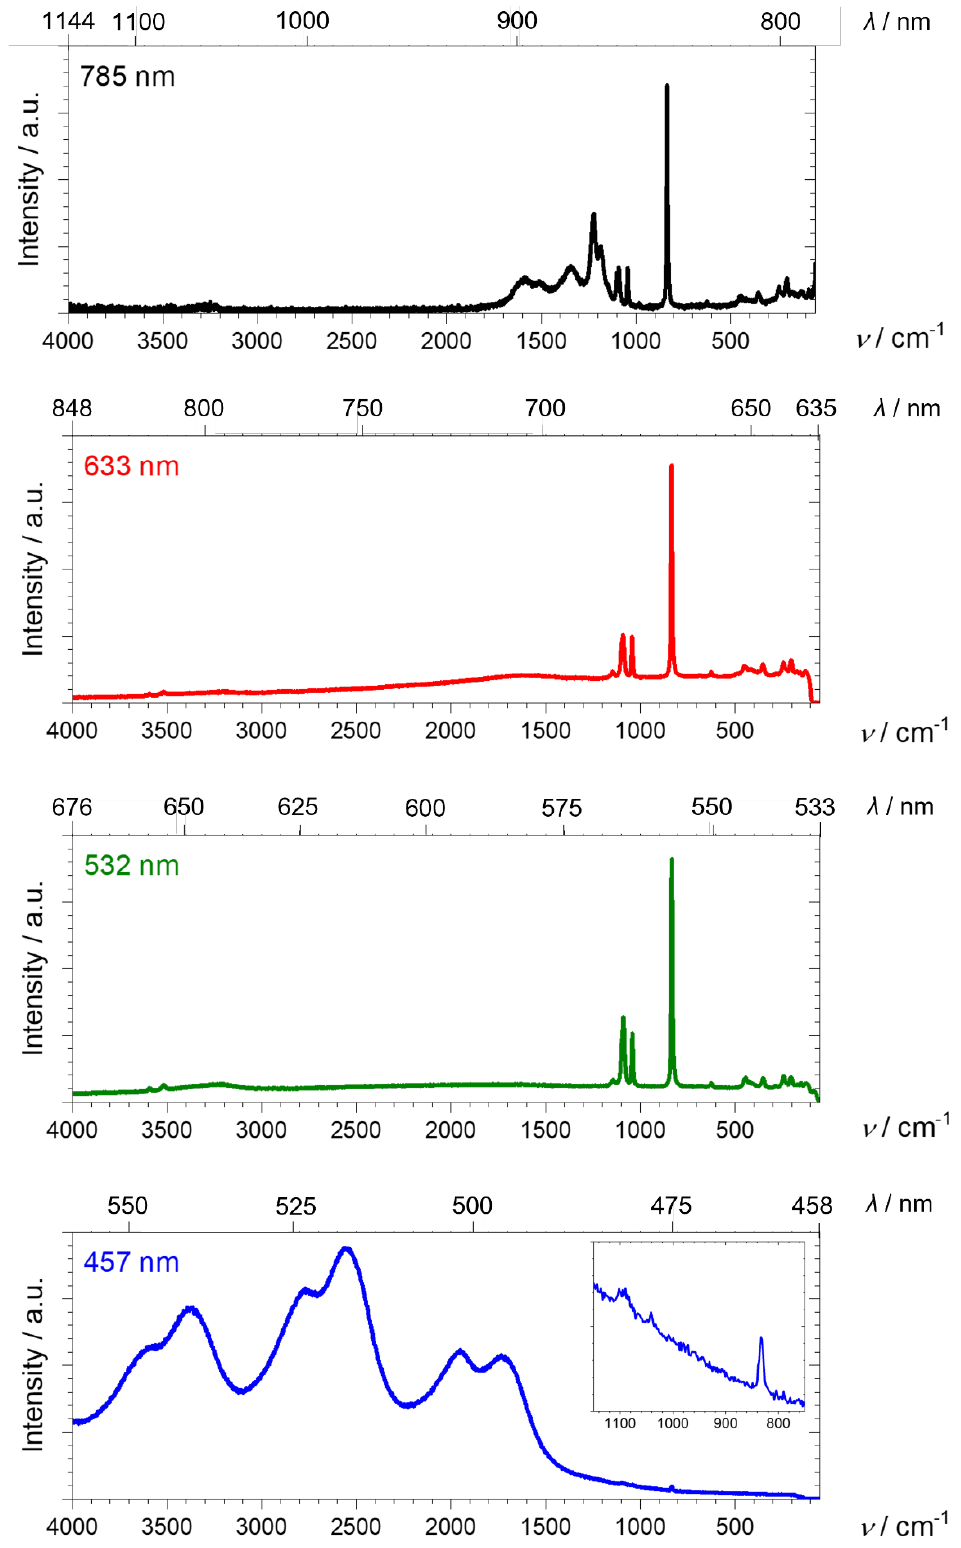
Figure 7. Raw johannite Raman spectra, obtained at four laser wavelengths (from top: 785, 633, 532, and 457 nm). For each plot, the Raman shift (in wavenumbers, ν ) is shown on the bottom axis and the corresponding wavelength shift from the Raman laser wavelength, λ s (in nm; as derived using Equation (1)), on the top axis of each spectrum. The intensity is given in arbitrary units (a.u.).